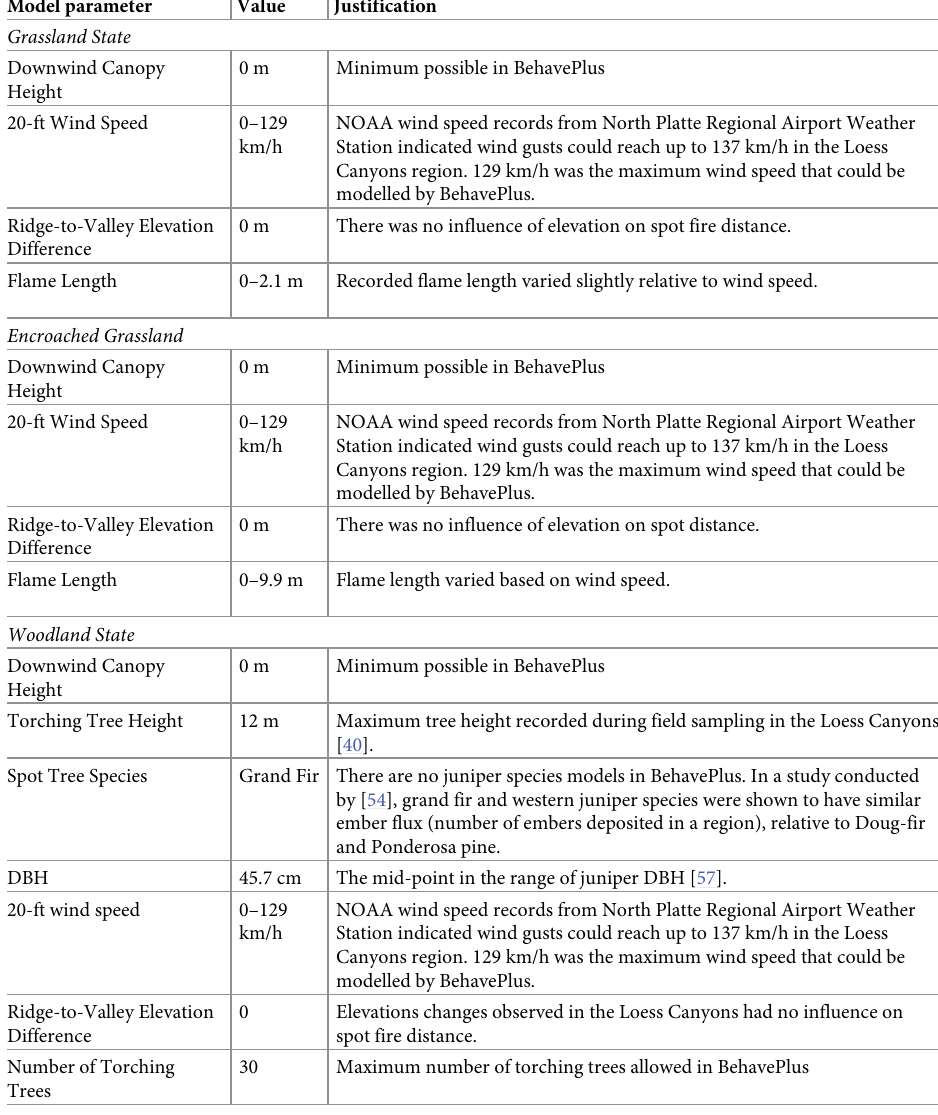
Table 3. Fuel model parameters and justification for spot fire distance